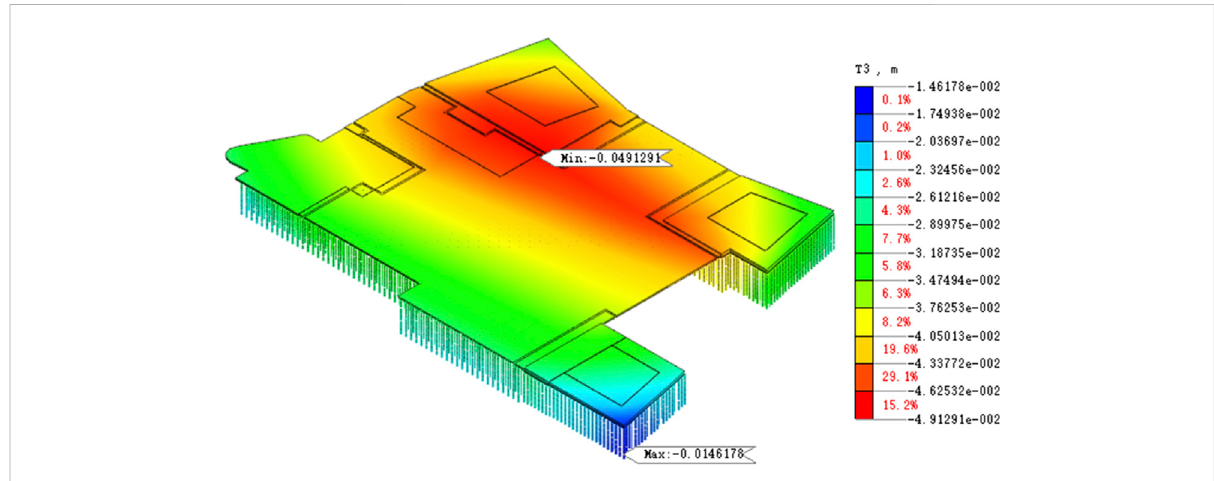
FIGURE 9 The overall settlement contour diagram in the complete construction stage of scheme combination